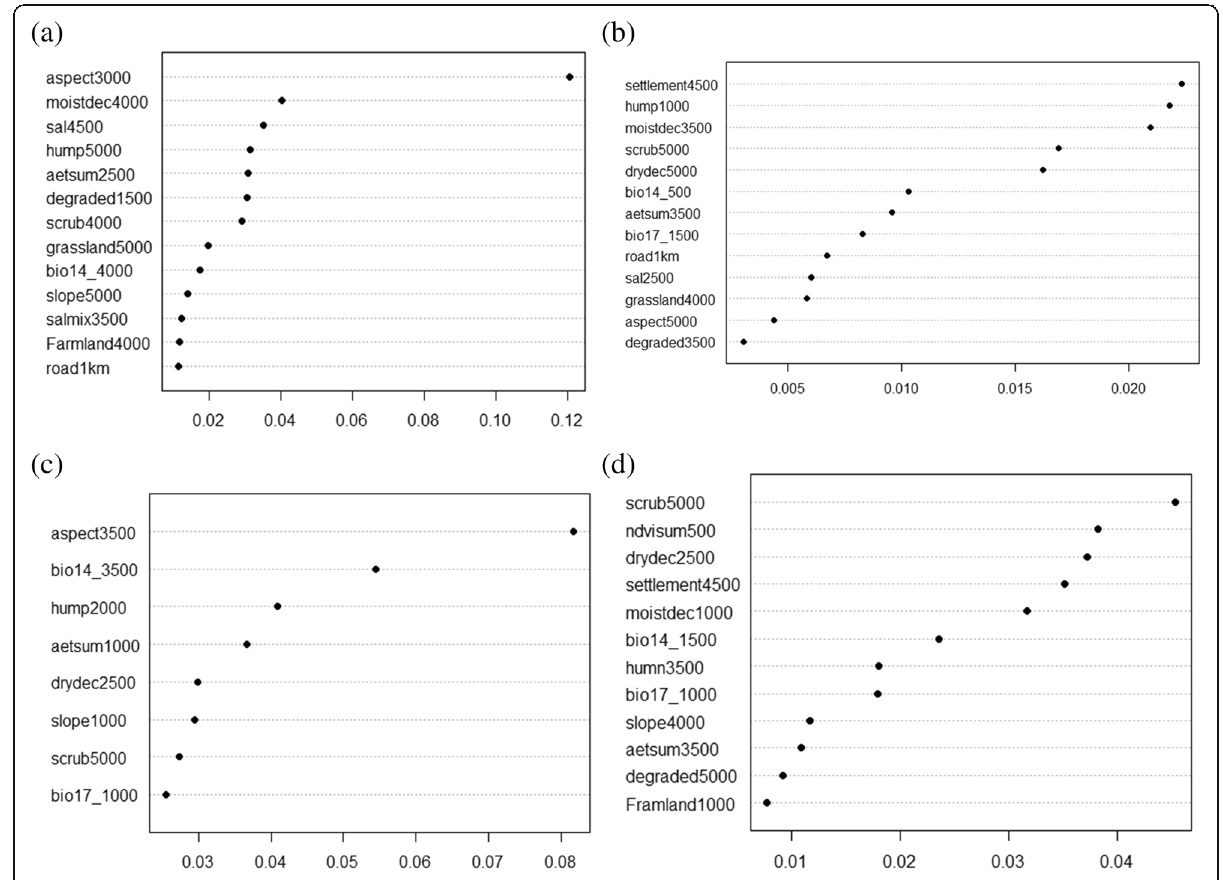
Fig. 4 Model improvement ratio plot (MIR) for the selected variables in the random forest model of a Indian fox, b jungle cat, c golden jackal, and d Asiatic wildcat. The x -axis indicates the relative additional model improvement when adding each successive